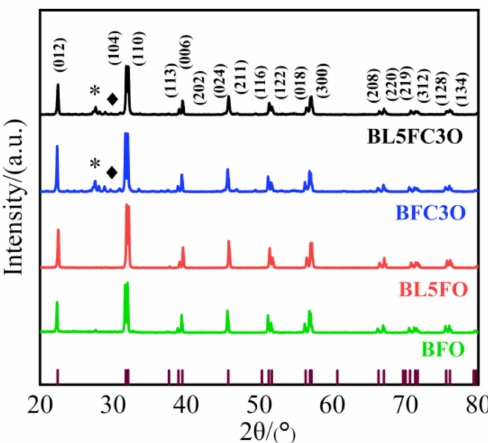
Figure 4. XRD diffractograms of pure BFO and elemental doped BFO. "*" indicates the impurity phase, the main component is Bi 2 Fe 4 O 9 ; " (cid:7) " indicates the impurity phase free of the unit